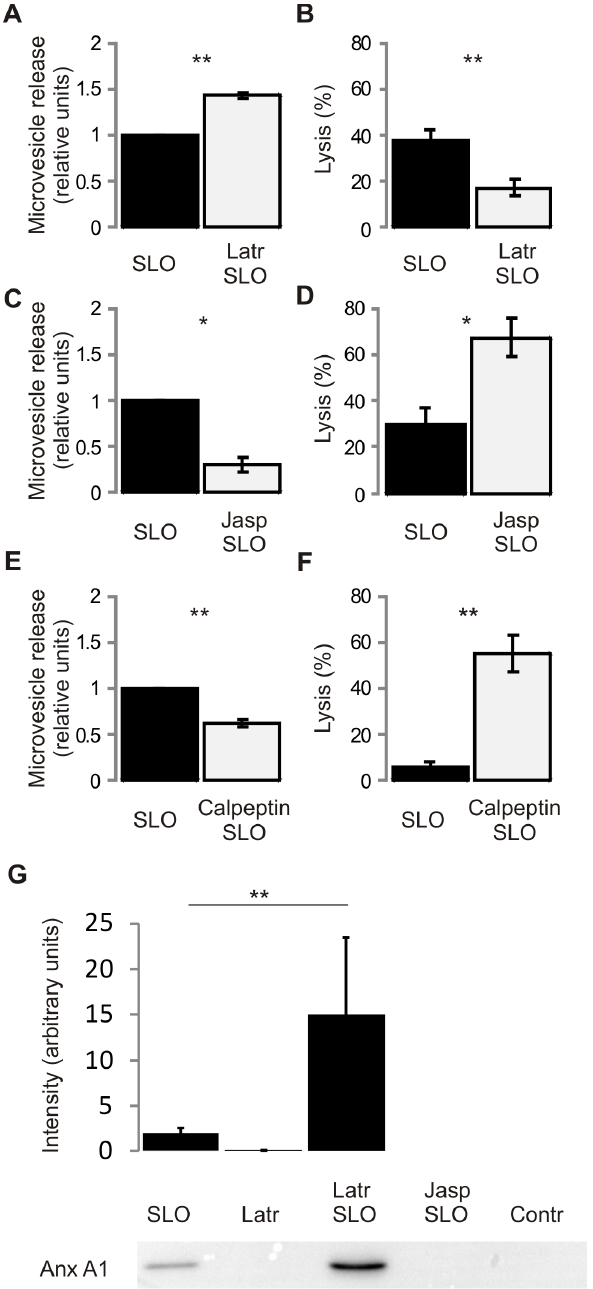
Figure 2. Destabilization of the cortical cytoskeleton enhances microvesicle release by SLO-damaged cells and potentiates their survival. ( A ) Enhanced release of microvesicles by SLO-damaged cells, which were treated with latrunculin A. ( B ) Latrunculin A protects HEK 293 cells from SLO-induced cell lysis. ( C ) Diminished release of microvesicles by SLO-damaged cells which were treated with jasplaki- nolide. ( D ) Treatment with jasplakinolide results in increased cell lysis. ( E ) Calpeptin reduces microvesicle release by SLO-damaged cells. ( F ) SLO induces an increased rate of lysis in calpeptin-treated cells. **p , 0.001, *p , 0.01. (G) Amounts of annexin A1 shed within microvesicles were analyzed by Western Blotting in culture supernatants of SLO- treated cells pre-treated with either latrunculin (Latr/SLO), jasplakinolide (Jasp/SLO), cells treated with latrunculin without SLO treatment (Latr) or cells treated with DTT only (Contr). **p , 0.001.